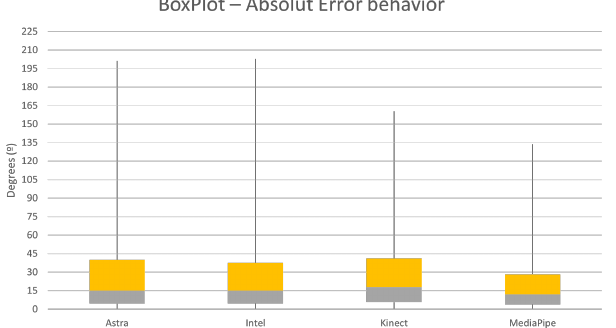
Figure 10. Box plot of the absolute error of each sensor in relation to Qualisys, for the lower limb